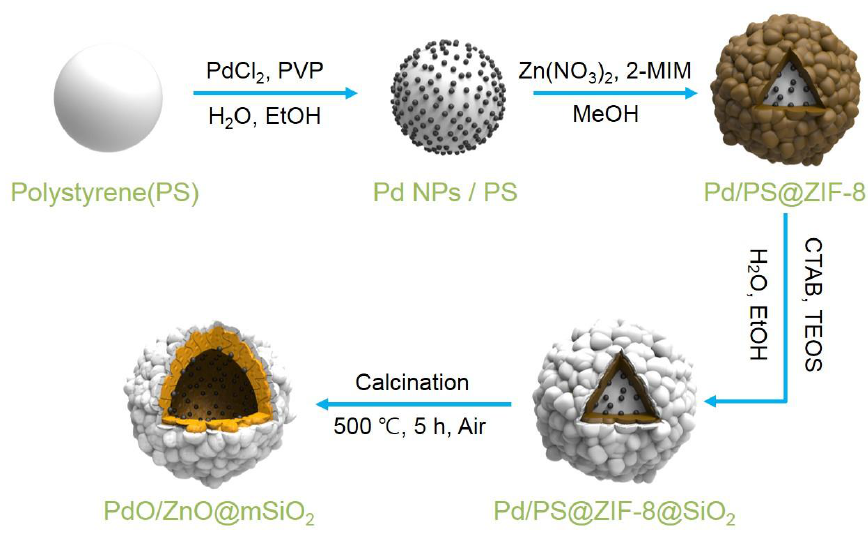
Scheme 1. Synthetic route for the PdO/ZnO@mSiO 2 hybrid nanocatalyst.